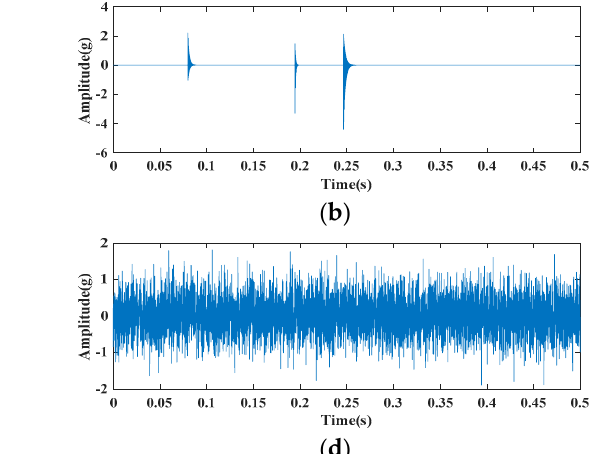
Figure 2. Comparison of the four indexes.